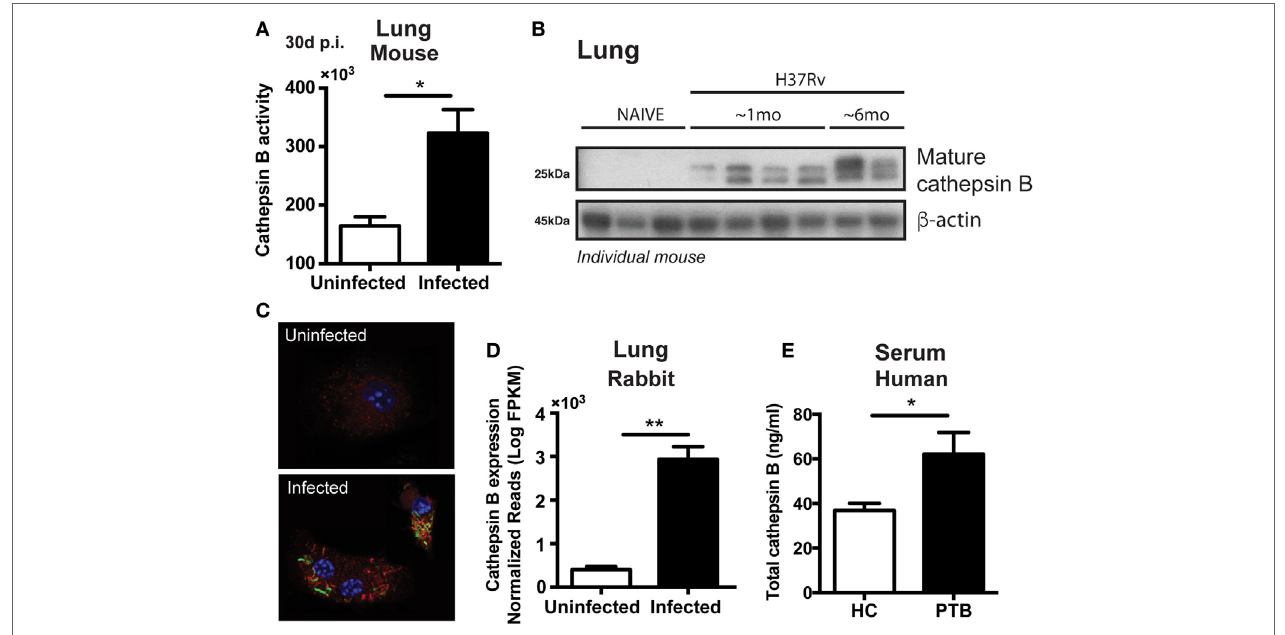
FigUre 1 | Mycobacterium tuberculosis (Mtb) infection upregulates both cathepsin B (CTSB) expression and enzymatic activity. (a) CTSB activity and (B) expression of mature CTSB were measured in the lungs of H37Rv-infected mice after 1 month or 6 months post-infection (mean ± SEM, n = 5). (c) CTSB activity (red) in macrophages infected (multiplicity of infection: 3) with GFP-H37Rv Mtb strain (green) was analyzed by confocal microscopy (magnification: 600 × ). DAPI (blue) was used for nuclear staining. Representative images are shown. (D) CTSB messenger RNA expression was quantified in lung granulomatous lesions from rabbits infected with Mtb H37Rv at day 42 post-infection (mean ± SEM, n = 3–4). (e) Total CTSB levels in plasma from patients with active pulmonary TB (PTB; mean ± SEM, n = 13) and health controls (HC; mean ± SEM, n = 12). Data were analyzed using the Mann–Whitney U test (* p < 0.05; ** p < 0.01). Data are representative of at least two separate experiments